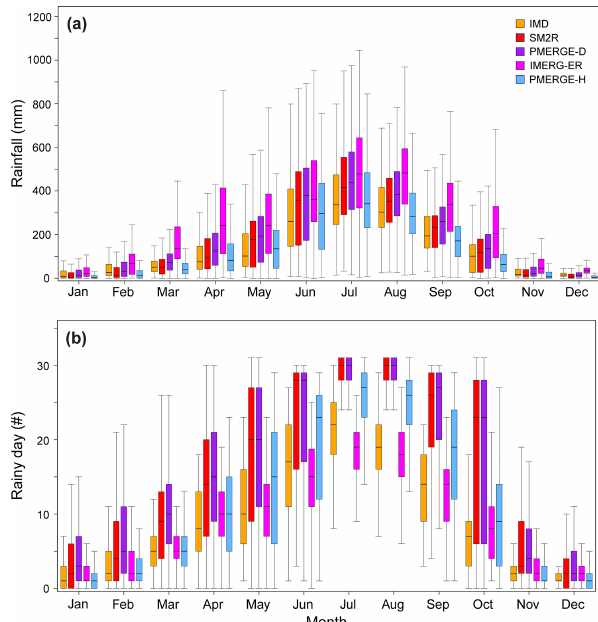
Figure 7. Box-and-whisker plots showing the distribution of (a) the monthly amount of rainfall as estimated by the satellite-based and measured ground-based products in the selected pixels and (b) the monthly number of rainy